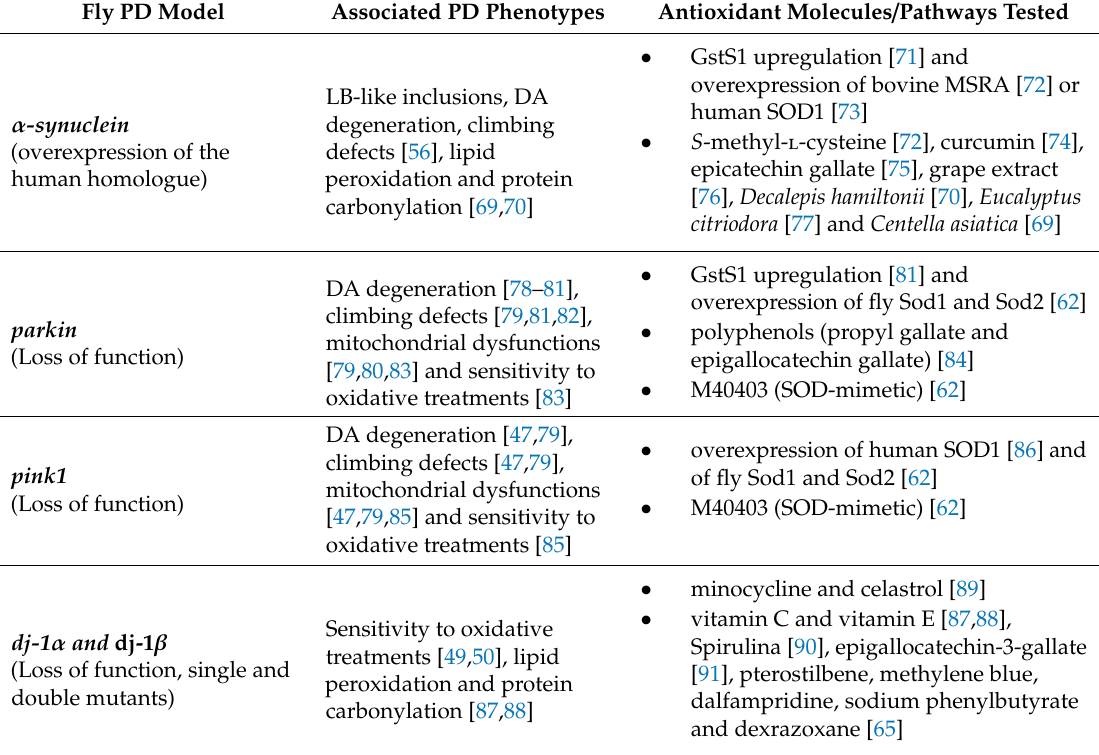
Table 1. Antioxidant treatments positively evaluated in Drosophila genetic PD